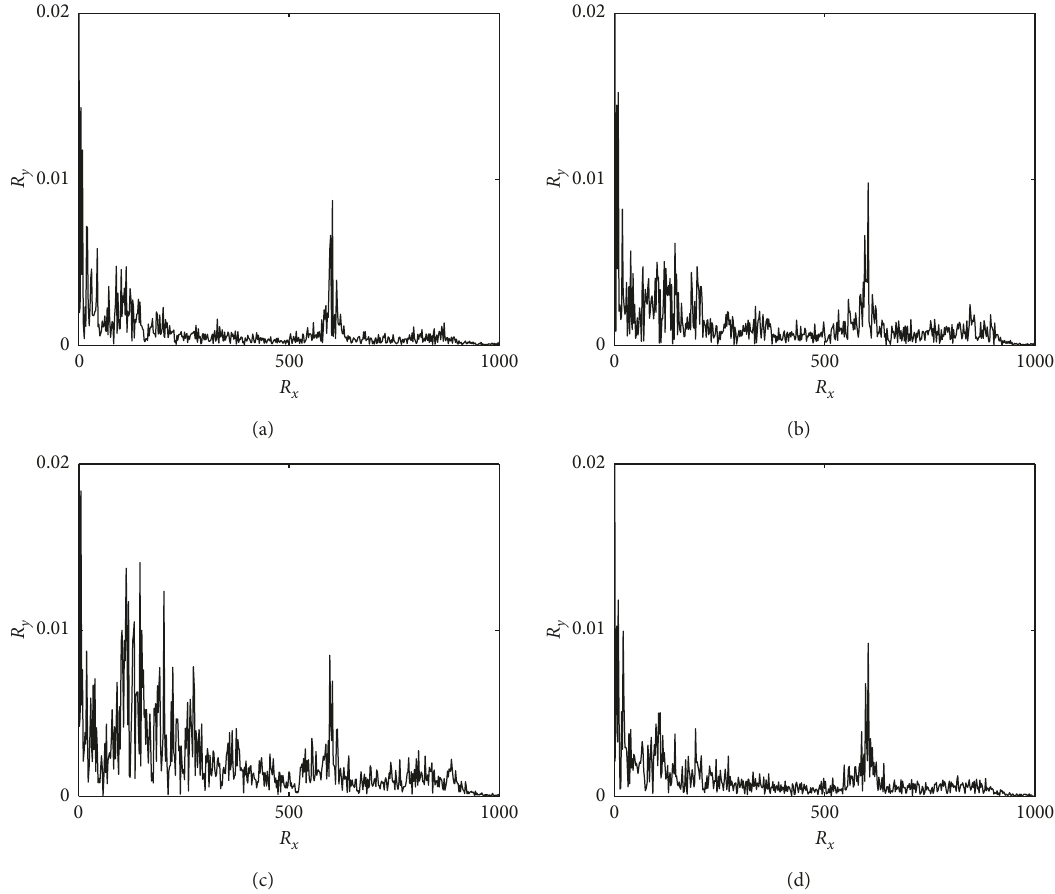
Figure 7: The adjusted spectrum images of dataset A: (a) NO; (b) IF; (c) OF; (d) BF.